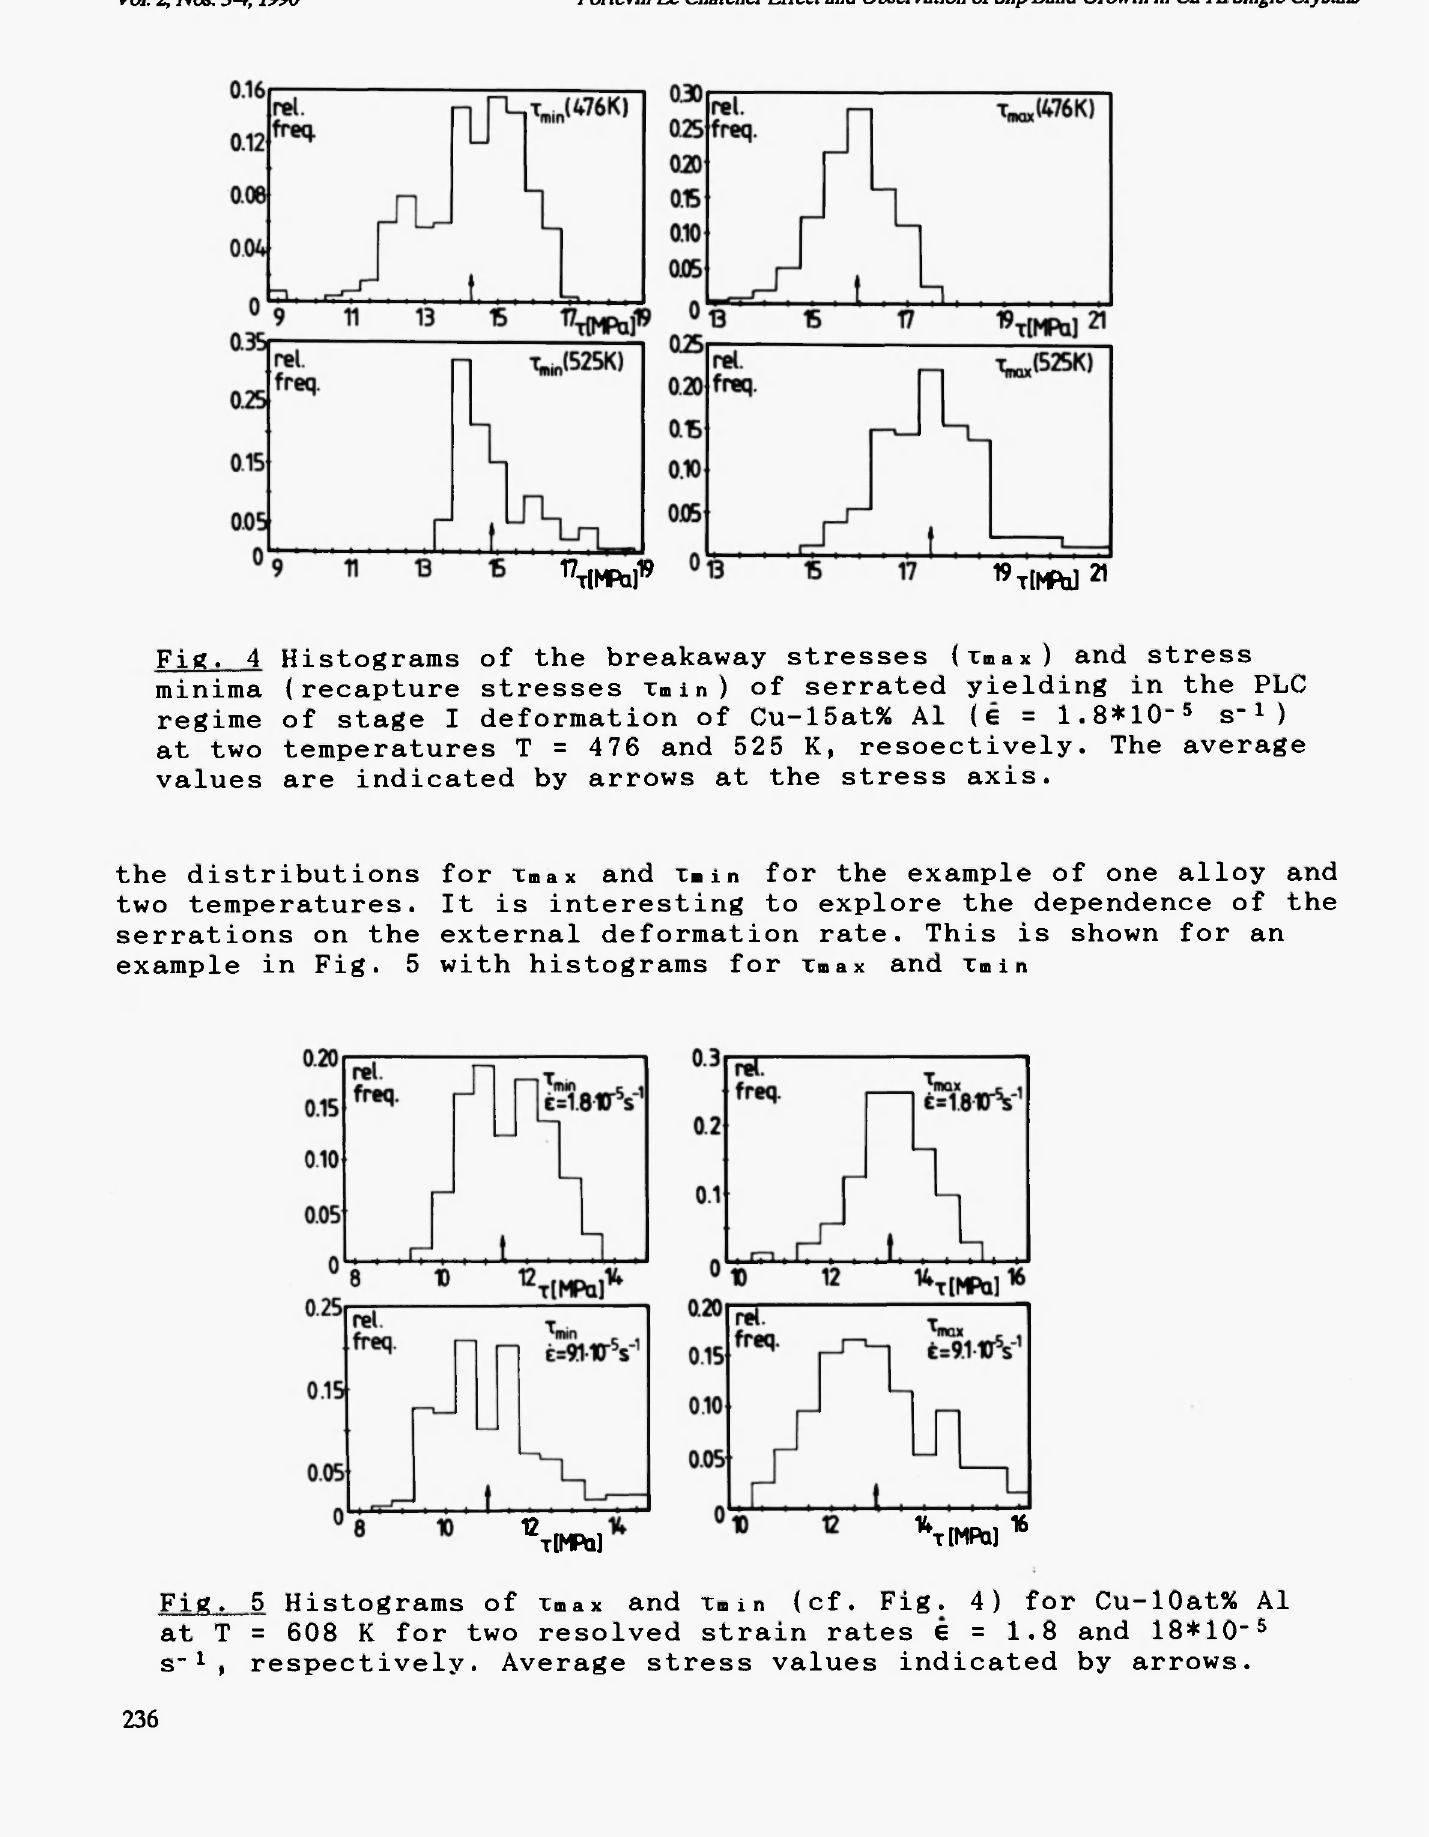
Fig. 5 Histograms of Xmax and tiin (cf. Fig. 4) for Cu-10at% Al at Τ = 608 Κ for two resolved strain rates e = 1.8 and 18*10" 5 s~ 1 , respectively. Average stress values indicated by arrows.